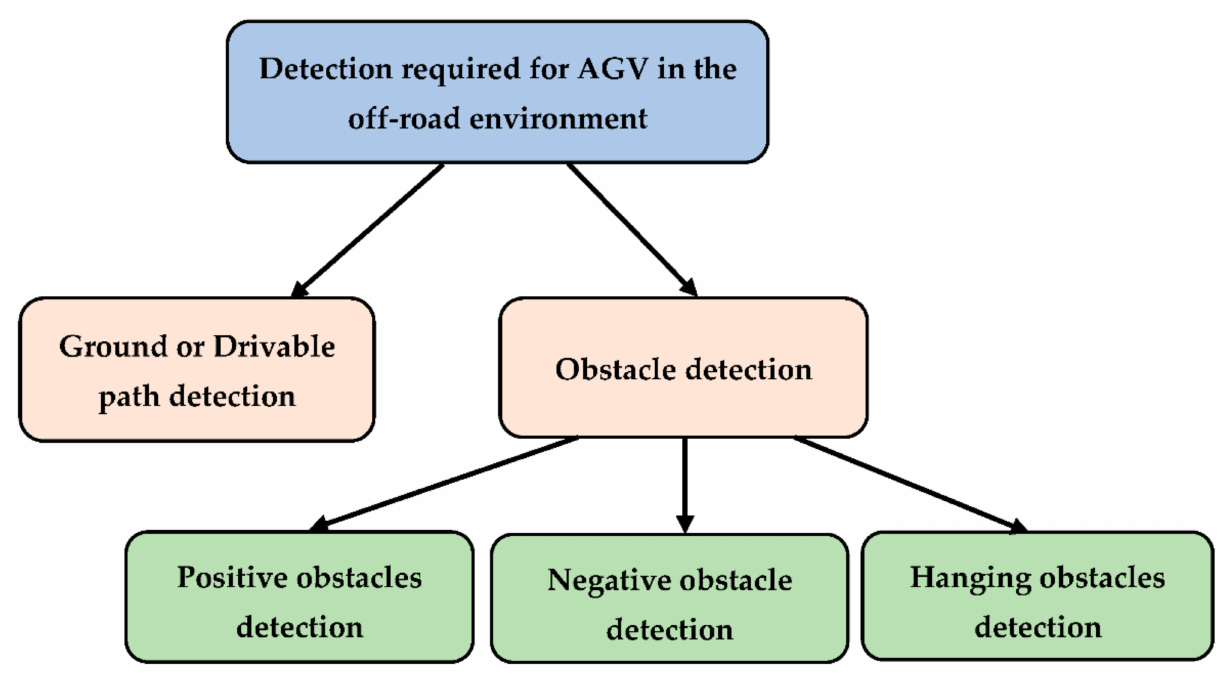
Figure 2. Classification of detection for AGV navigation in the off-road environment.